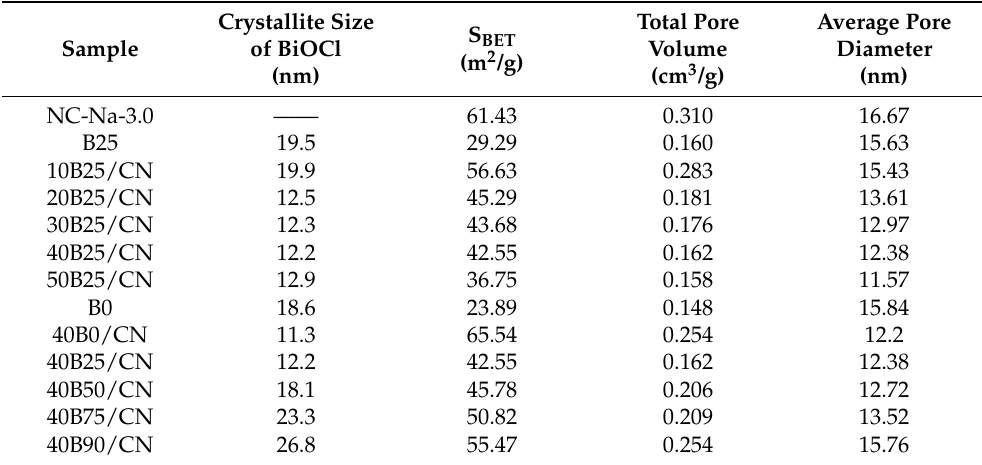
Table 2. Specific surface area, total pore volume, average pore diameter, and crystallite size of different